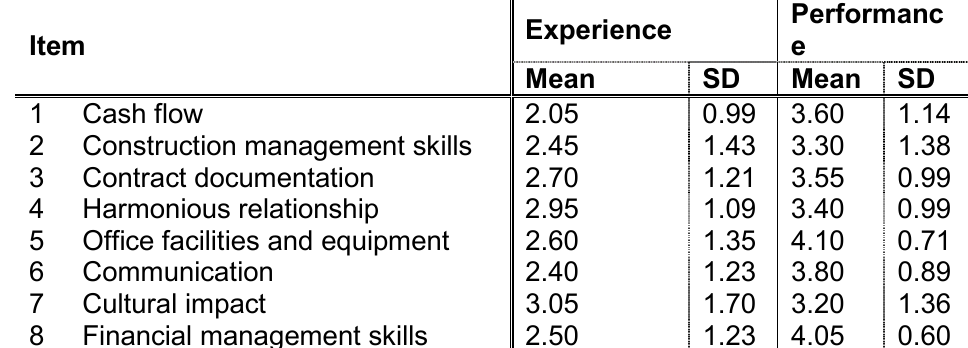
Table 2: Summary of respondent’s source and main areas of work